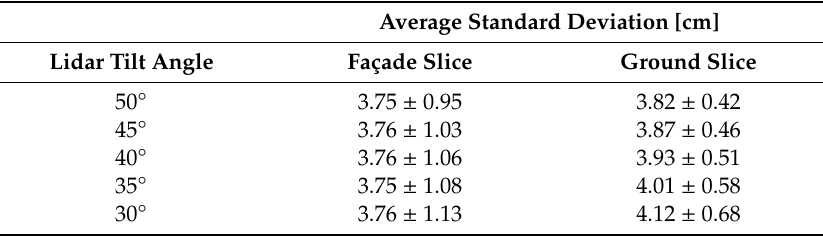
Figure 18. The relation between the Pandar64 Lidar tilt angle and the incidence angle where red points having ≥20° incidence angle on the ground. ( a ) @ 15°tilting angle: the average angle of incidence ≈14°  5°. ( b ) @ 30° tilting angle: the average angle of incidence ≈23°  9°. ( c ) @ 50° tilting angle: the average angle of incidence ≈44°  22°.